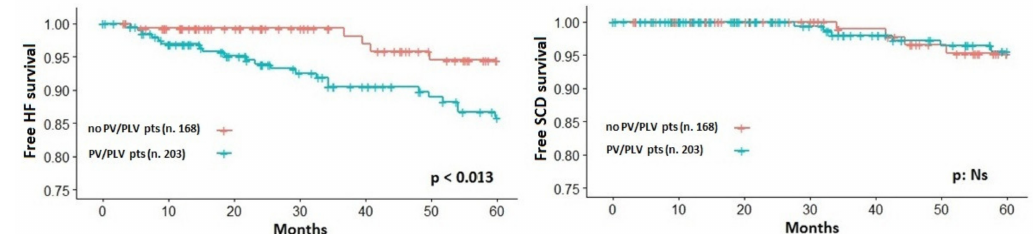
Figure 3. Kaplan–Meier estimator of survival free from heart failure (HF, left panel ) and sudden cardiac death (SCD, right panel ) related events according to the presence of likely pathogenic / pathogenic sarcomeric variants (PLV /